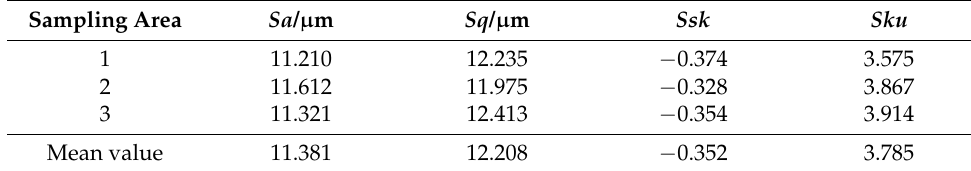
Table 2. Roughness parameters of grinding wheels with different areas.